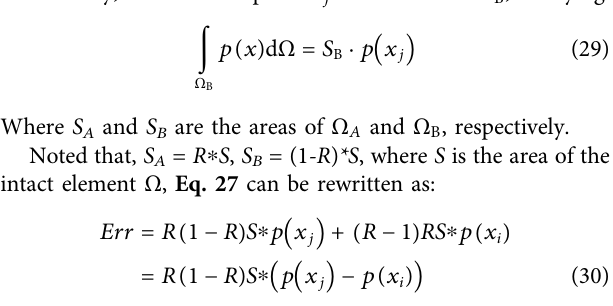
1 The red lines represent the discontinuous interfaces, and the arrows point